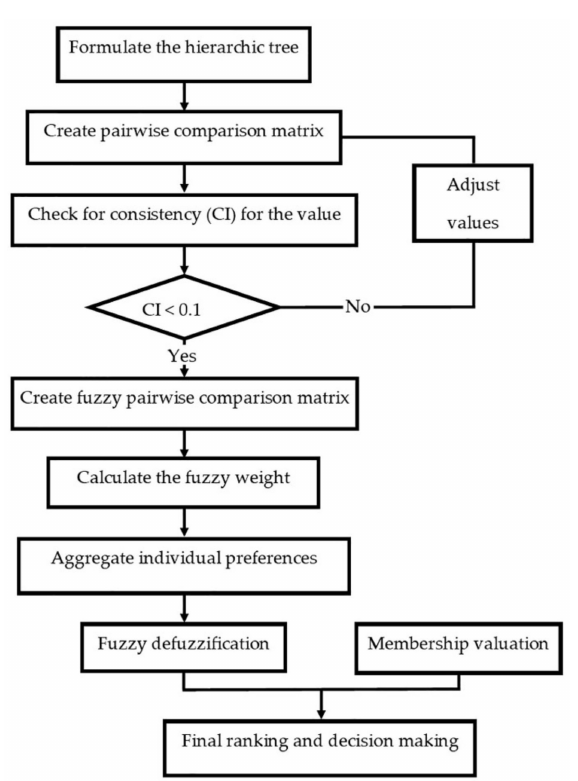
Figure 3. The proposed methodology for Fuzzy Analytical hierarchical process